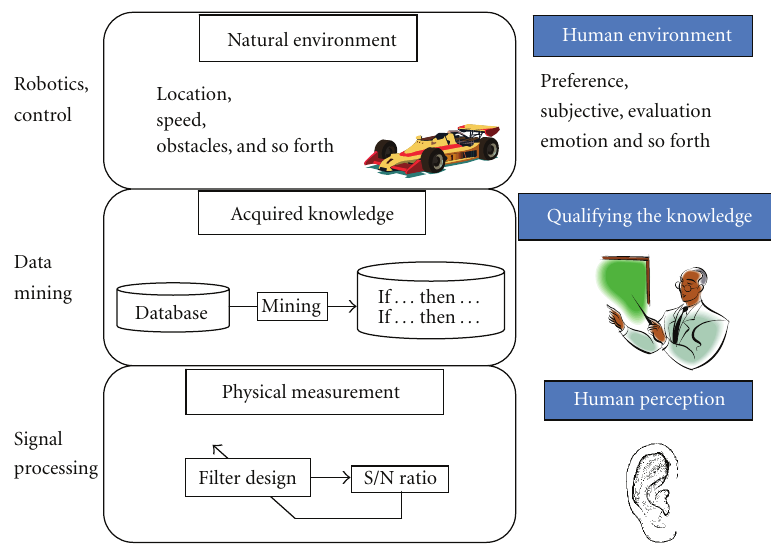
Figure 1: Human factors have become important in conventional